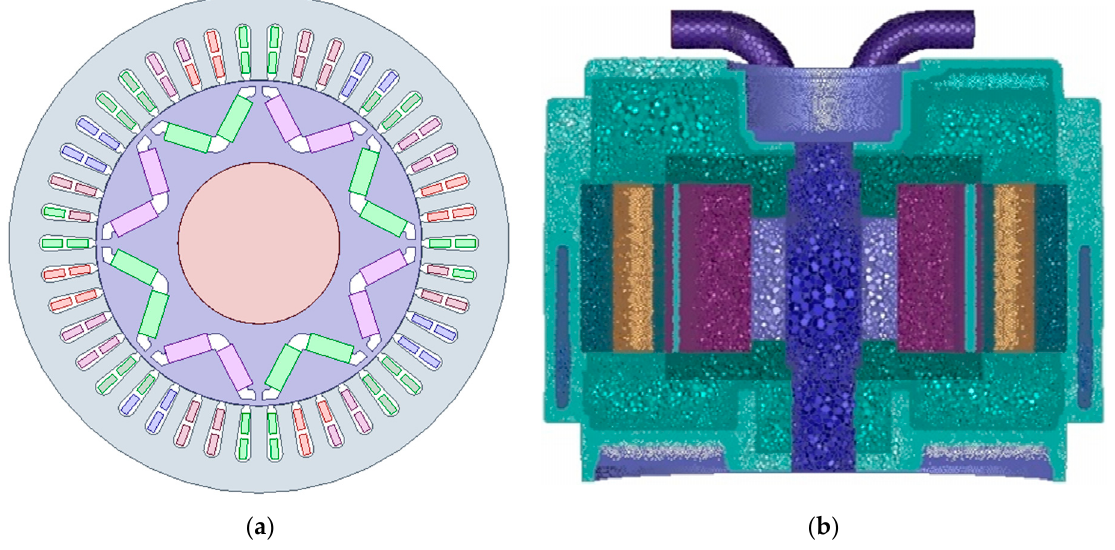
Figure 6. Motor model. ( a ) Electromagnetic model; ( b ) cross-sectional mesh.